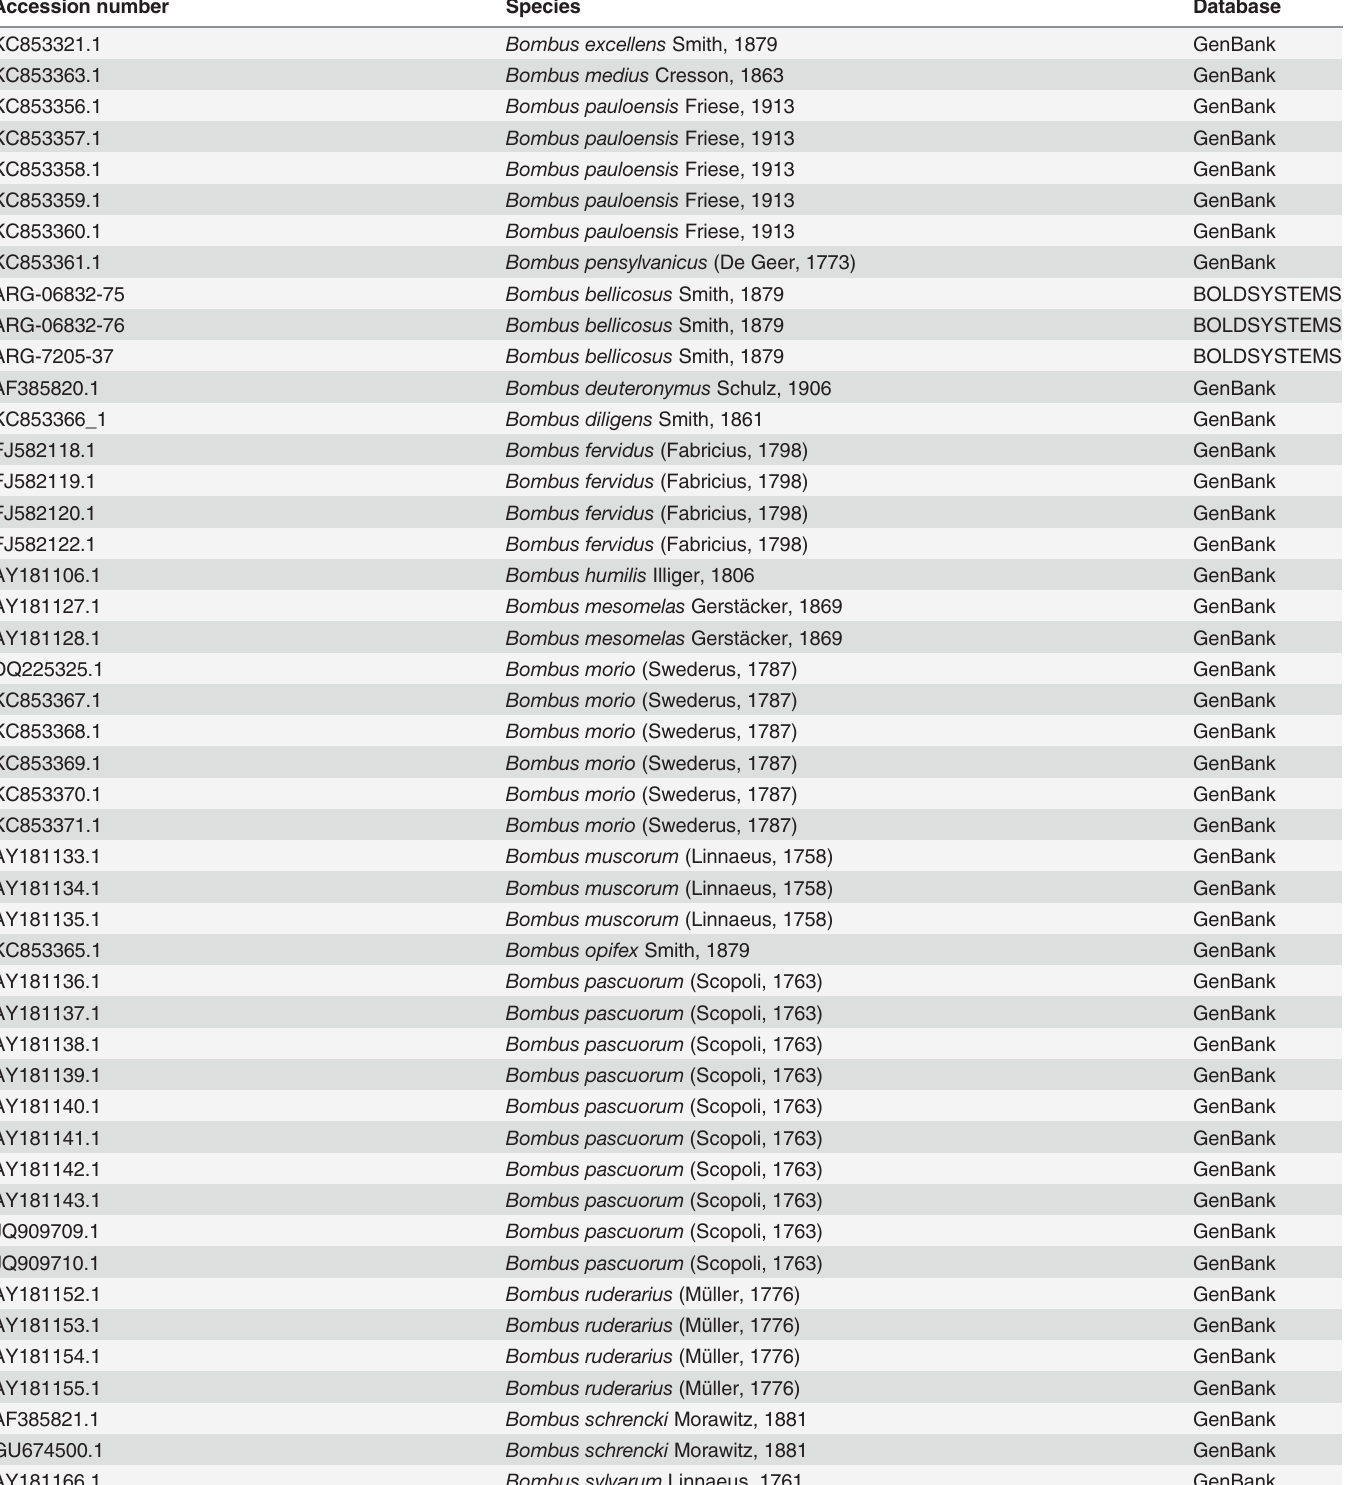
Table 1. Specimens belonging to GenBank and BOLD Systems databases, which were used in analyzes with the COI